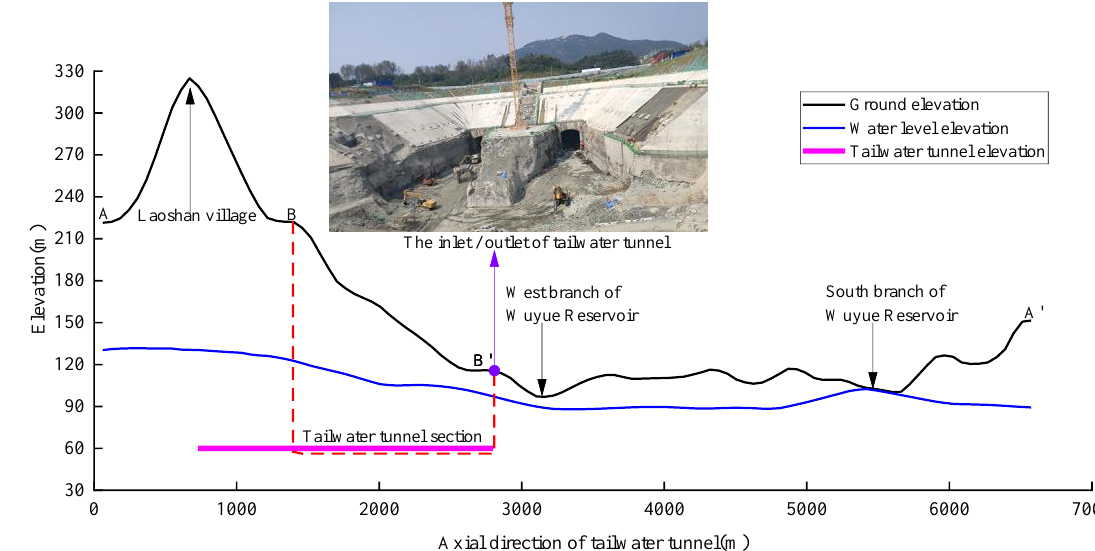
Figure 5. Groundwater occurrence along the A–A’ transect.